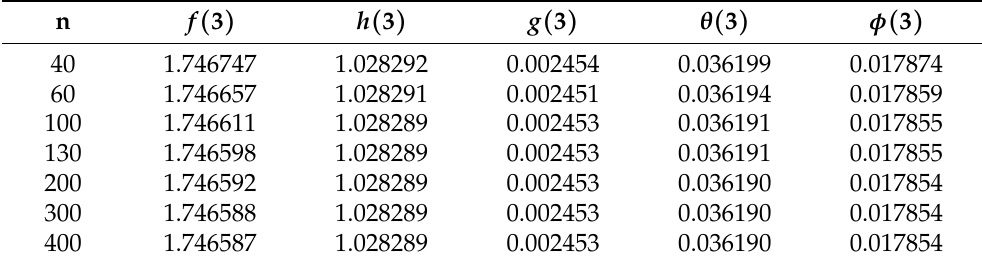
Table 1. The finite element scheme convergence against a number of elements ( n ), when R = 1, Pr = 2, C = 0.5, Nb = 0.5, Nt = 0.5, Le = 2, K = 5, γ = 1.0, λ = 1, λ 1 = 0.1, β = 0.2, (cid:101) = 0.5, Nr = 1, m = 0.5, f w = 0.2, Rd =